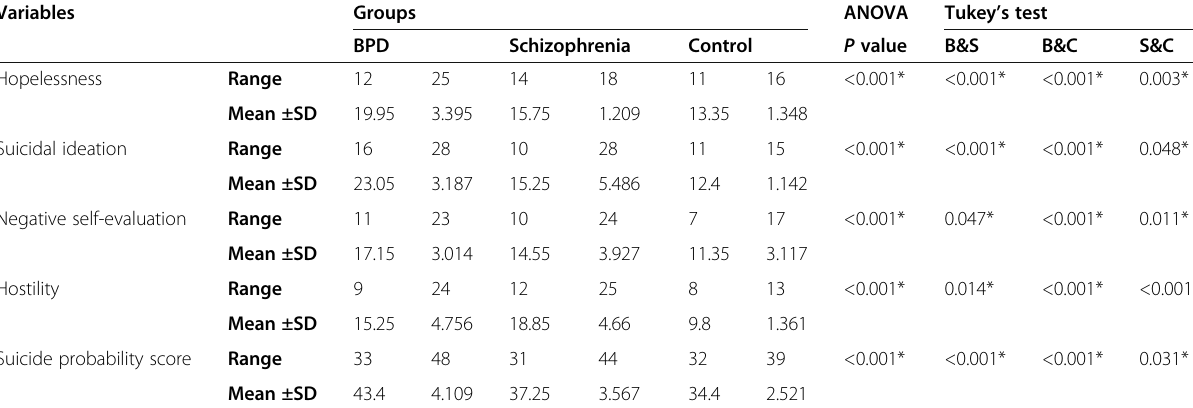
Table 3 Comparison of suicide probability among the studied groups